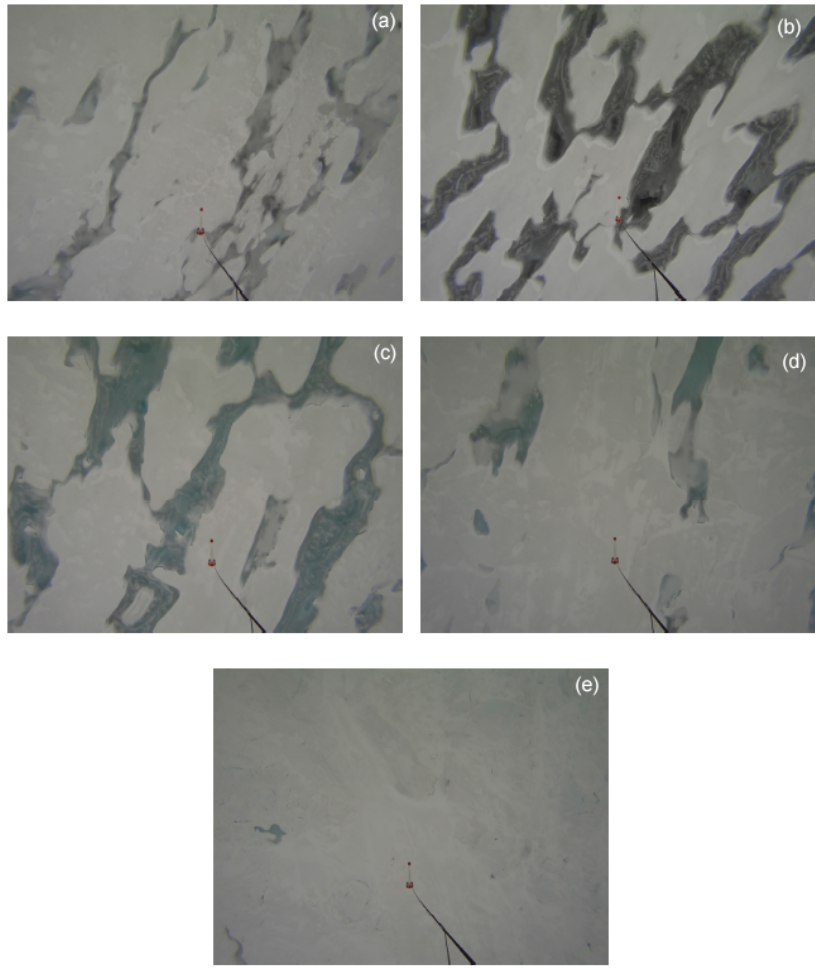
Figure 4. Example photos from the five regions of interest: (a) ROI1, (b) ROI2, (c) ROI3, (d) ROI4 and (e) ROI5. The photos are captured during the helicopter flight on 3 September 2011, and the EM-bird can be seen in the lower centre part of each photo.